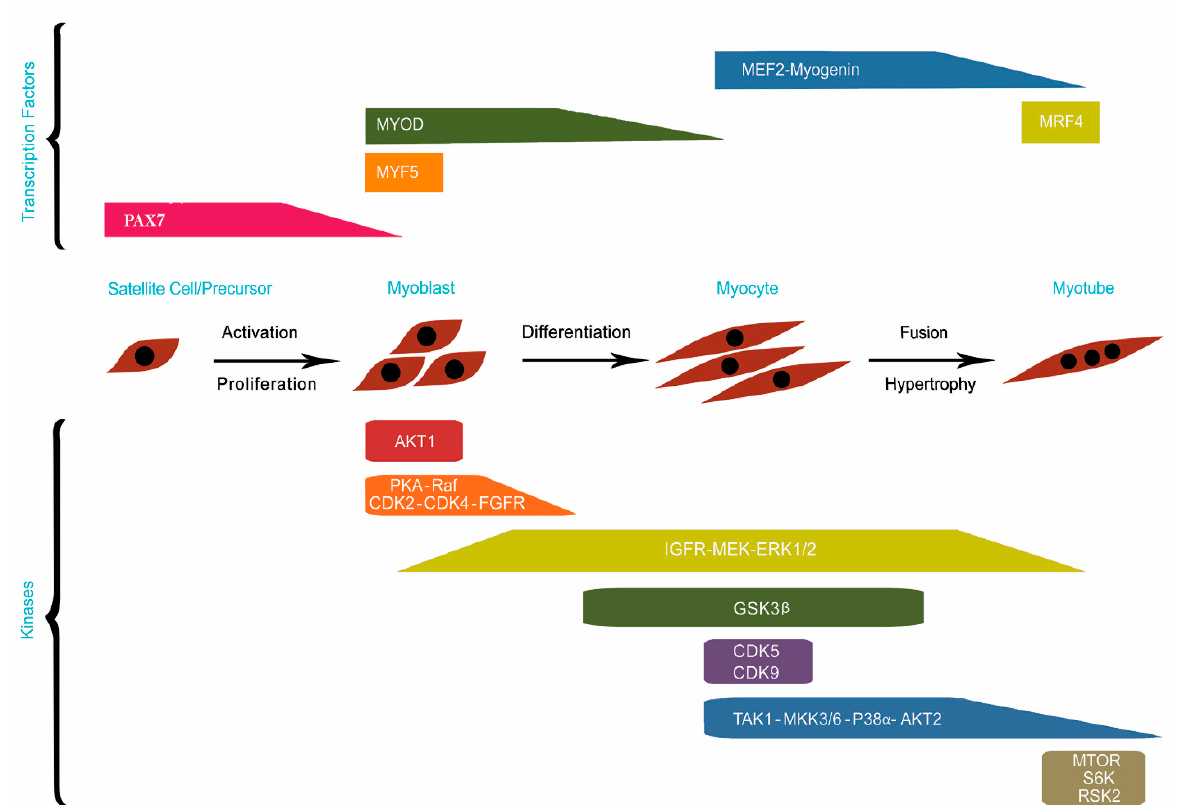
Figure 1. The involvement of myogenic transcription factors and protein kinases in the regulation of different stages of myogenesis. Embryonic precursors or quiescent satellite cells proliferate and construct myoblasts. Myoblasts then undergo differentiation to form myocytes. Finally, multinucleated myotubes are formed as a result of fusion of myocytes. The upper and lower sections of the figure illustrate transcription factors and protein kinases required for myogenesis, respectively (modified from